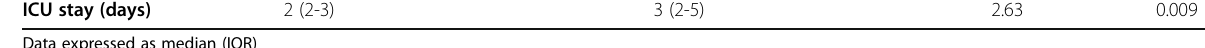
Table 5 Comparison between the two studied groups regarding ICU stay Pre diabetic group ( N = 20)